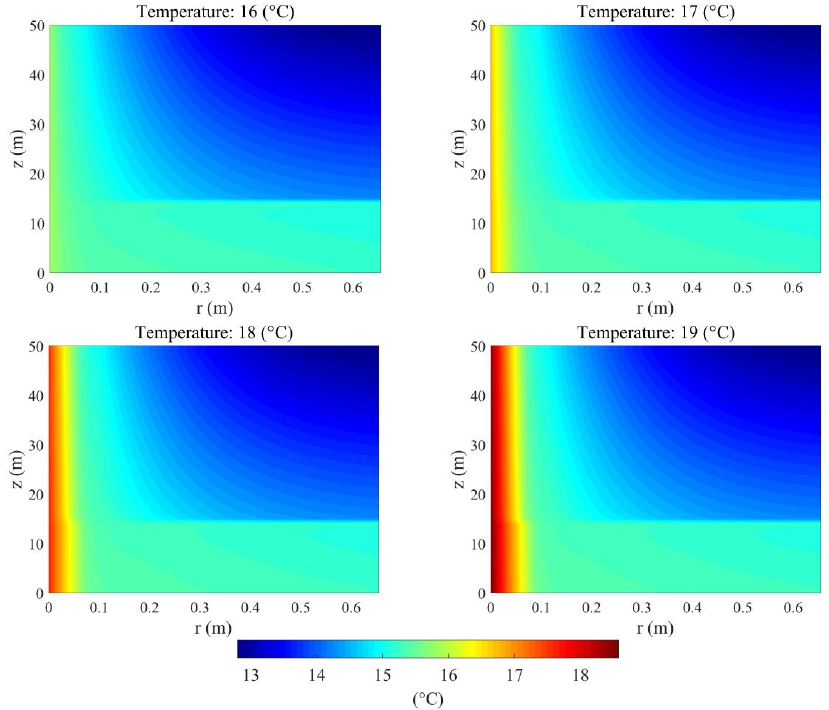
Figure 7. Comparison of two-dimensional temperature distribution of hydrate reservoirs for a fixed salinity of 3.05 wt% at the 24th hour of drilling fluid invasion under different drilling fluid temperatures.